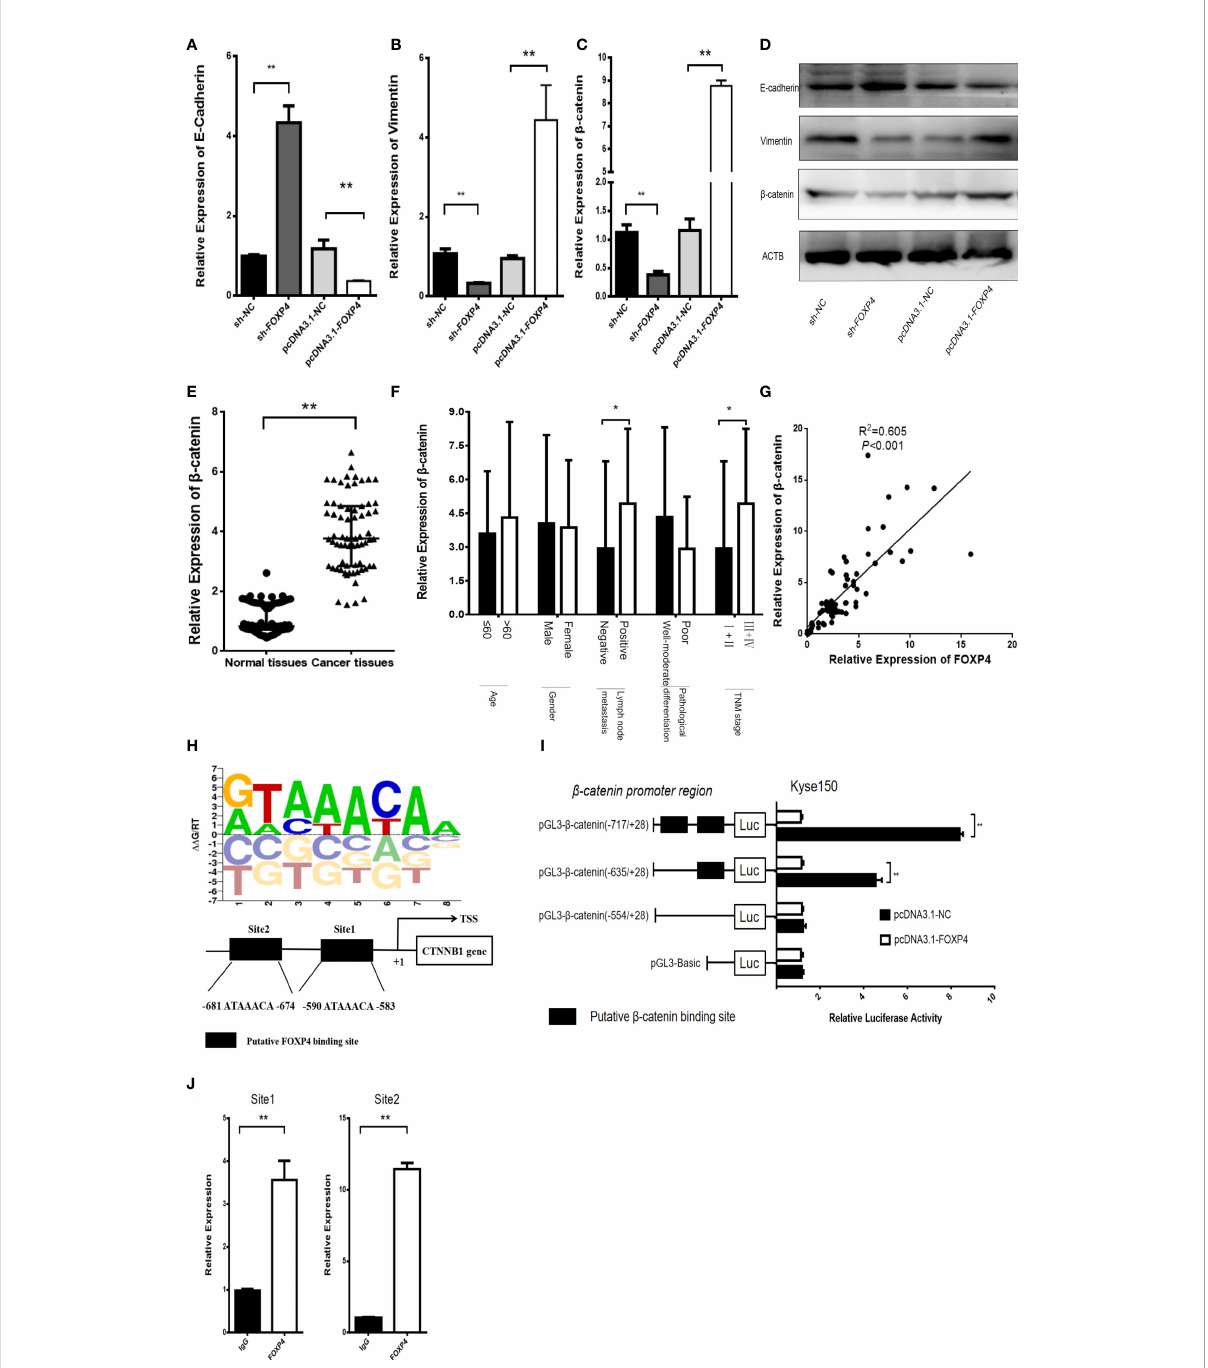
FIGURE 6 FOXP4 regulates b -catenin expression as a transcription factor. The mRNA (A – C) and protein (D) levels of EMT ‐ related genes (E ‐ cadherin, b - catenin, and Vimentin) with sh ‐ FOXP4 or pcDNA3.1-FOXP4 by qRT – PCR or WB. The expression of b -catenin in ESCC (E) and different subgroups (F) by qRT – PCR. (G) The correlation between FOXP4 and b -catenin by qRT – PCR. (H) The predicted FOXP4 binding site sequence in the promoter of b -catenin. (I) The effect of FOXP4 on the luciferase activity of b -catenin by dual-luciferase reporter assay. (J) The direct interaction of FOXP4 with the b -catenin promoter by ChIP. * p < .05 and ** p ≶